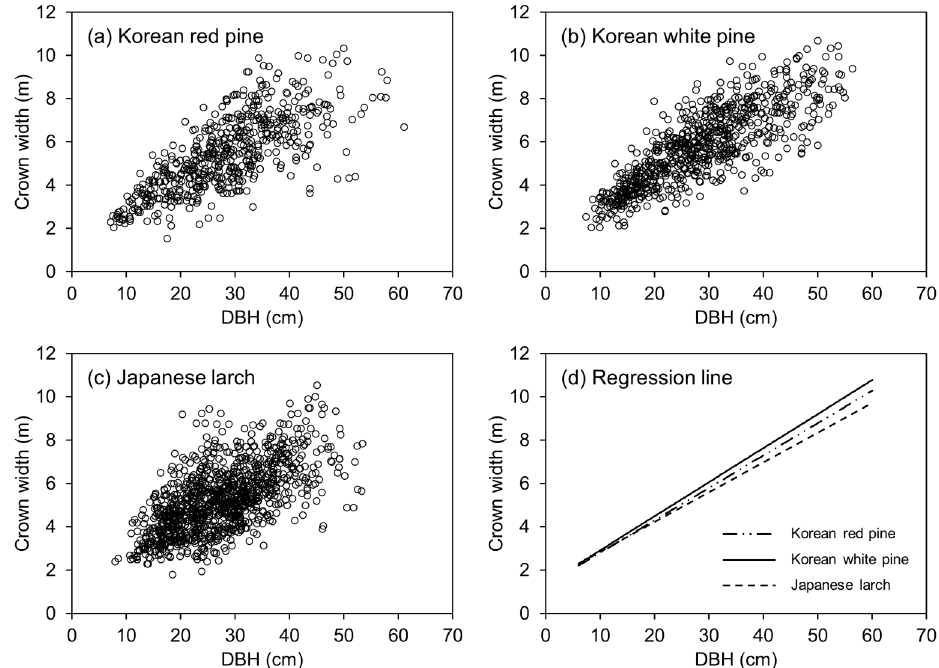
Figure 4. Scatterplots of crown width (CW) over diameter at breast height (DBH) for ( a ) Korean red pine, ( b ) Korean white pine, and ( c ) Japanese larch used for modeling B-level stocking. CW-DBH ( d ) regression lines by species via Equation (6) displayed using fixed effects of Equation (9) developed in Table